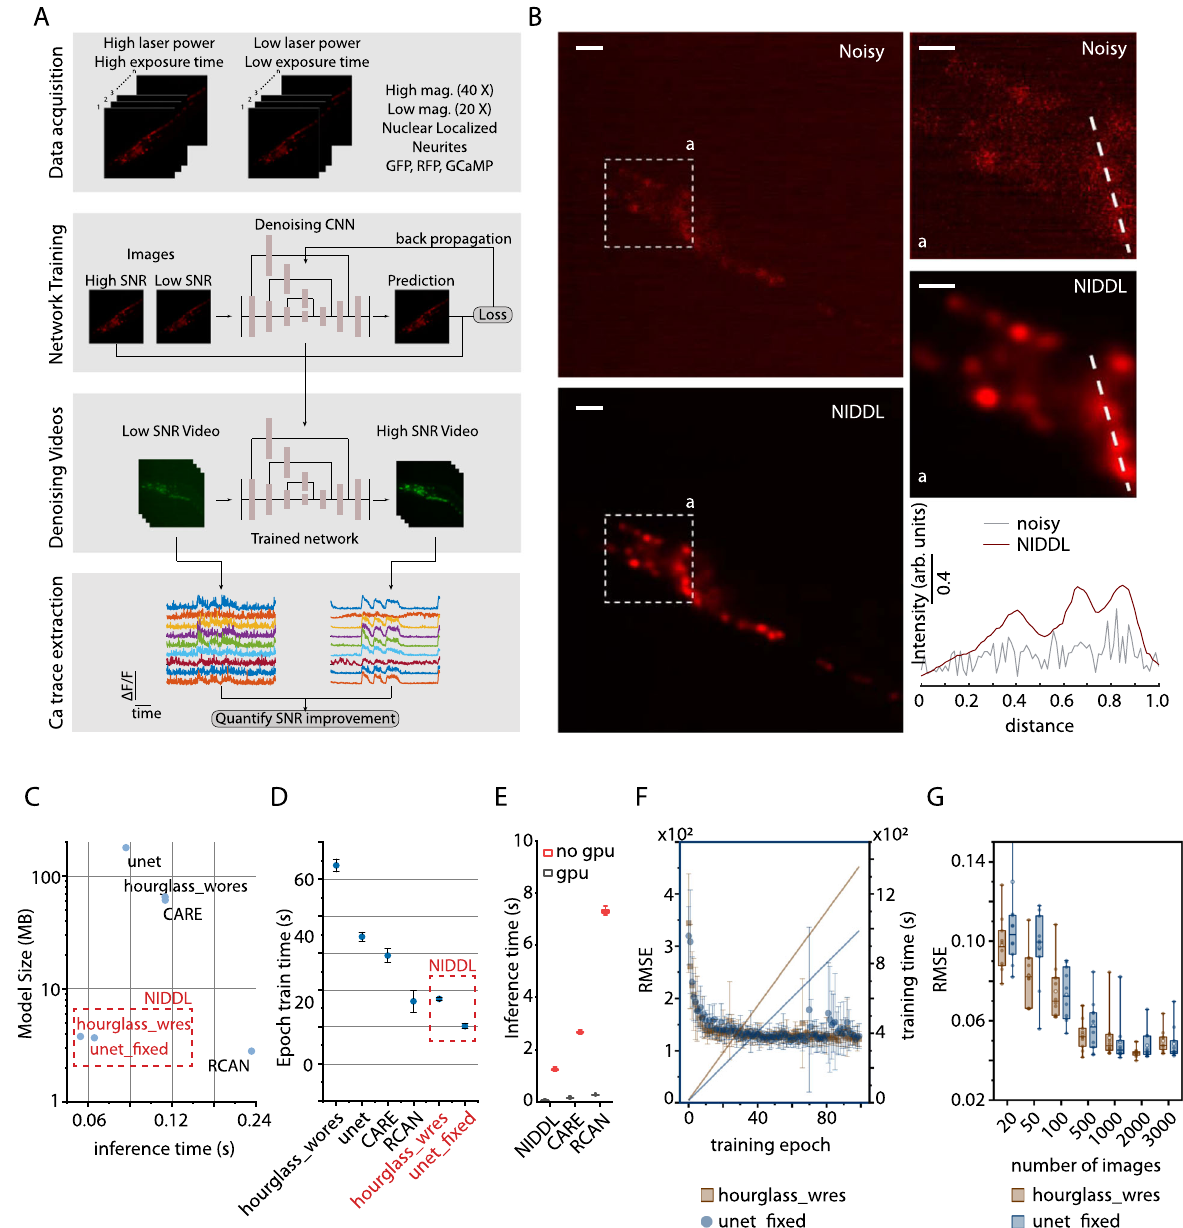
Fig. 1 | Neuro-Image Denoising with Deep Learning (NIDDL) framework. A Overview of the SL framework to recover high SNR from a variety of imaging conditions. B Anexamplenoisyimage(1zplanefrom3Dstack,strainOH16230)and corresponding deep-denoised image (scale bar 10 μ m). Top-right panels show insets ‘ a ’ in noisy and denoised images (scale bar 5 μ m). Bottom-right panel shows intensity along dotted lines in noisy and deep denoised images. C The optimized neural network architectures ‘ unet_ fi xed ’ and ‘ hourglass_wres ’ have 20 – 30× lower modelsize (3.77 MB and 3.66 MB)and 3 – 4× fasterinference time(average 48.9ms and 68.7ms per 512×512 image calculated across 600images), compared to CARE, RCAN,and non-optimized UNet,Hourglass. D Per-epochtraining-timecomparison acrossneuralnetworkarchitecturevariants(batchsizeof50images,epochtraining sizeof1000).Eachdotcorrespondstoaverageepochtraintimeacross100epochs foreachinstanceoftrainednetworks.Errorbarsindicatestandarddeviationacross 5 – 10 instances of training with random subset of total data used for training each instance. E Denoising-timecomparisonofdeep-learningmethodswheninferenceis